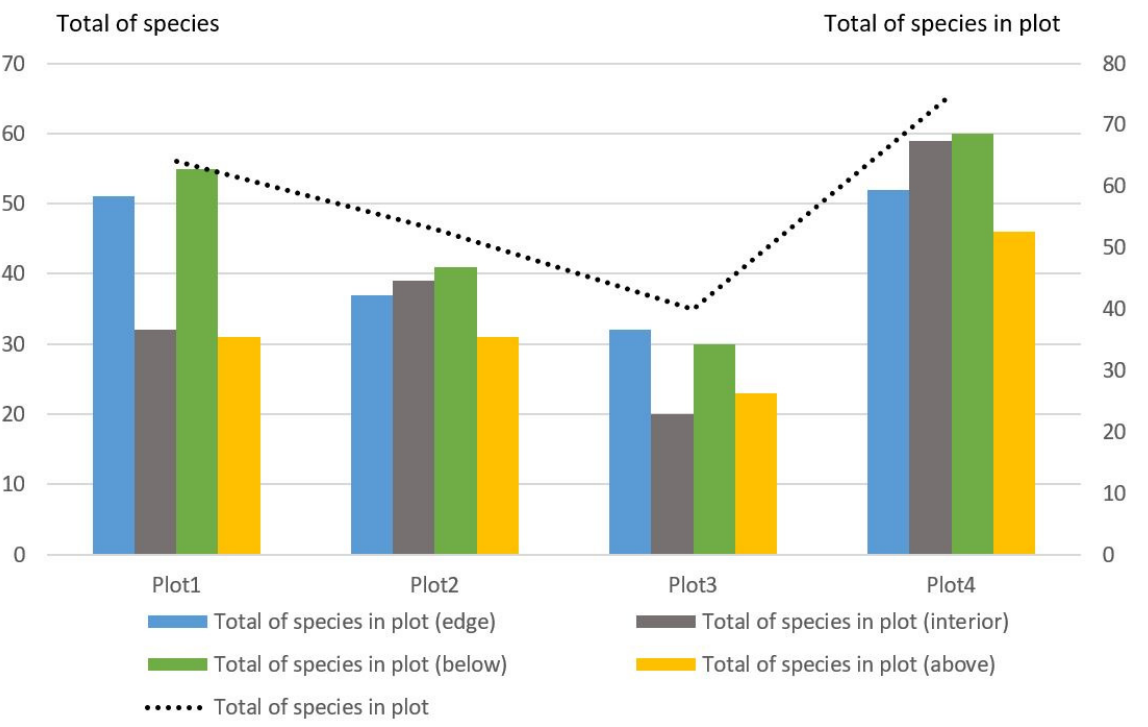
Figure 3. The species diversity of Coleoptera collected using beer traps on the edges and in the forest interior.